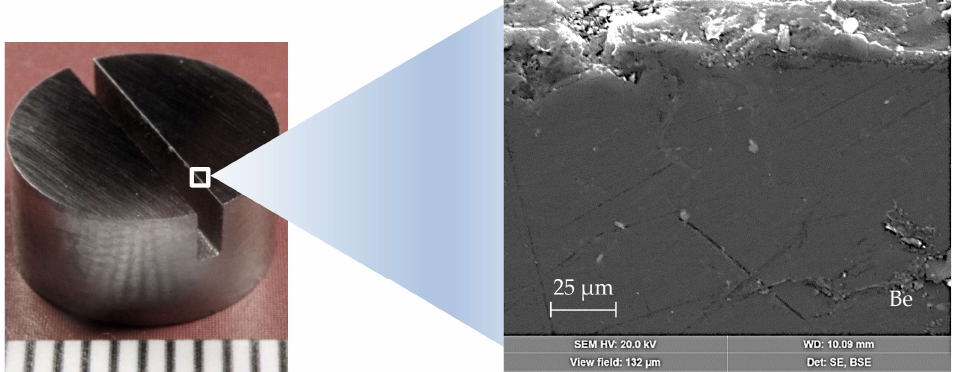
Figure 1. Initial beryllium sample ( left ) and an SEM image of the slit edge ( right